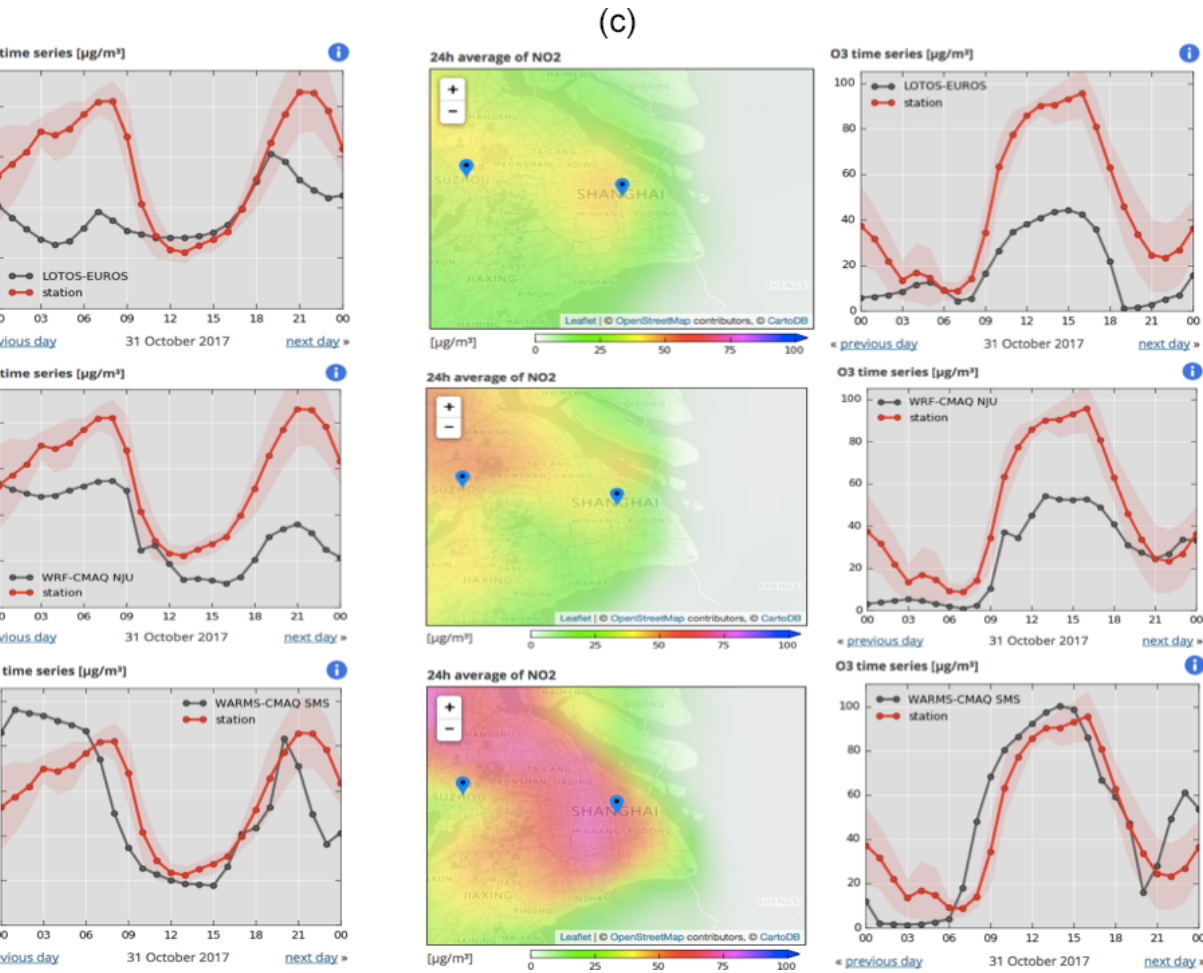
Figure 6. (a) Diversity in the NO 2 and ozone forecasts made for Shanghai on 31 October 2017 as highlighted by the predictions from several models included in the ensemble of the MarcoPolo–Panda system. The left and right columns show the diurnal variation in the predicted (black) and observed (red) NO 2 and ozone concentrations (µgm − 3 ), respectively. The center column presents the geographical distribution in the vicinity of Shanghai of the diurnal average predicted for the NO 2 concentration. The ensemble median is shown in the top row, and two individual forecasts as provided by CHIMERE and IFS are shown in the middle and lower rows. (b) Same as in (a) but for the individual forecasts from WRF-Chem-SMS, WRF-Chem-MPIM, and EMEP. (c) Same as (a) but for the individual forecasts from LOTOS-EUROS, WRF–CMAQ, and